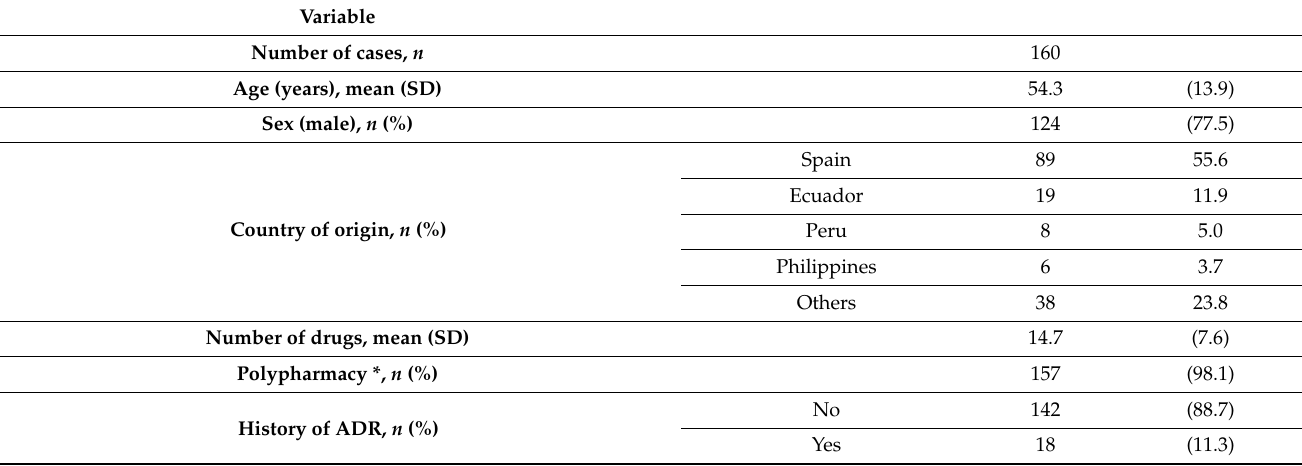
Table 1. Characteristics of